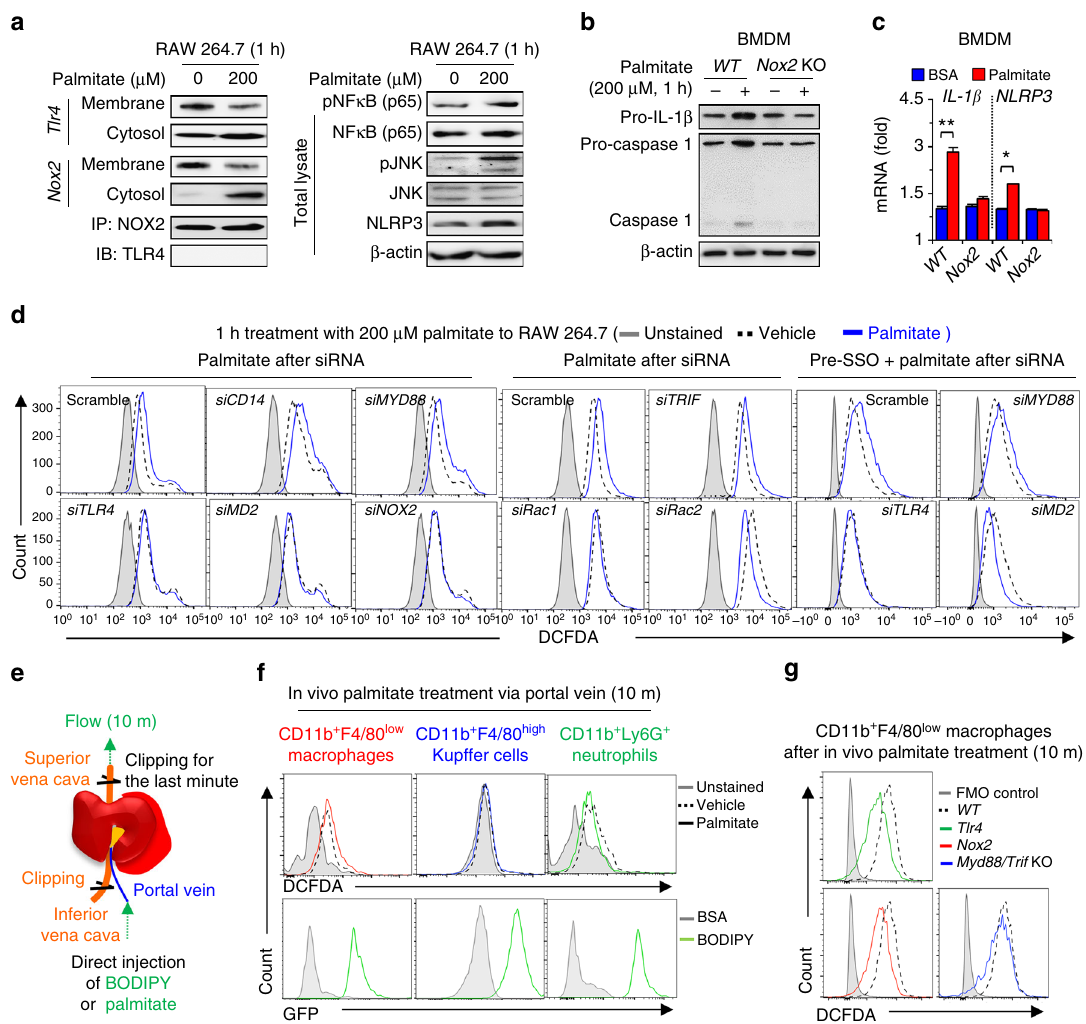
Fig. 5 Endocytosis of palmitate/TLR4 – MD2 complex generates NOX2-mediated ROS. a RAW 264.7 cells were stimulated with 200 μ M palmitate for 1 h. Total cell lysates, membrane fractions or cytosol fractions of RAW 264.7 cells were subjected to Western blotting or immunoprecipitation (IP). With anti- NOX2, immunocomplexes from cytosolic fractions were followed by immunoblot analysis with antibody of TLR4. b , c BMDMs of WT and Nox2 KO mice were stimulated with 200 μ M palmitate for 1 h and then they were subjected to Western blotting and qRT – PCR analyses, respectively. d RAW 264.7 macrophages were subjected to FACS analyses to measure ROS generation after each siRNA silencing. To inhibit CD36-mediated palmitate uptake, RAW 264.7 cells were pre-treated with sulfosuccinimidyl oleate (SSO) for 10 min. e Direct perfusion of the liver with palmitate. C-16 BODIPY (10 μ M) and palmitate (500 μ M) were infused via the portal vein for 10 minutes. Both the superior and inferior vena cava were clipped for the last one minute to trap the solution in the liver. f , g After perfusing C16-BODIPY or palmitate through the liver of WT, Tlr4 KO, Nox2 KO and Myd88/Trif double KO mice, successful delivery of C16-BODIPY and ROS generation were assessed in freshly isolated CD11b + F4/80 low macrophages, CD11b + F4/80 high Kupffer cells and CD11b + Ly6G high neutrophils, respectively. Data are representative of three independent experiments using isolated liver immune cells from 3 ( f , g ) mice per group. Data are expressed as the mean ± s.e.m. and analyzed by Student ’ s t -test, * P < 0.05, ** P < 0.01 in comparison with the corresponding